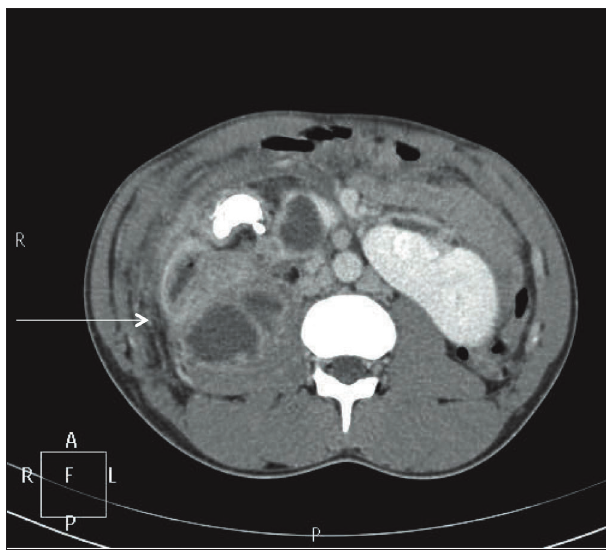
Fig. 3. Axial reformatted CECT of the abdomen revealing right-sided inflammatory perinephric fat stranding A horseshoe kidney represents the most common renal fusion anomaly, where the two kidneys are connected across the midline by an isthmus. Horseshoe kidneys are frequently complicated by obstruction, infection and calculus formation, and have an increased risk of renal malignancy development, especially Wilms’ tumour.